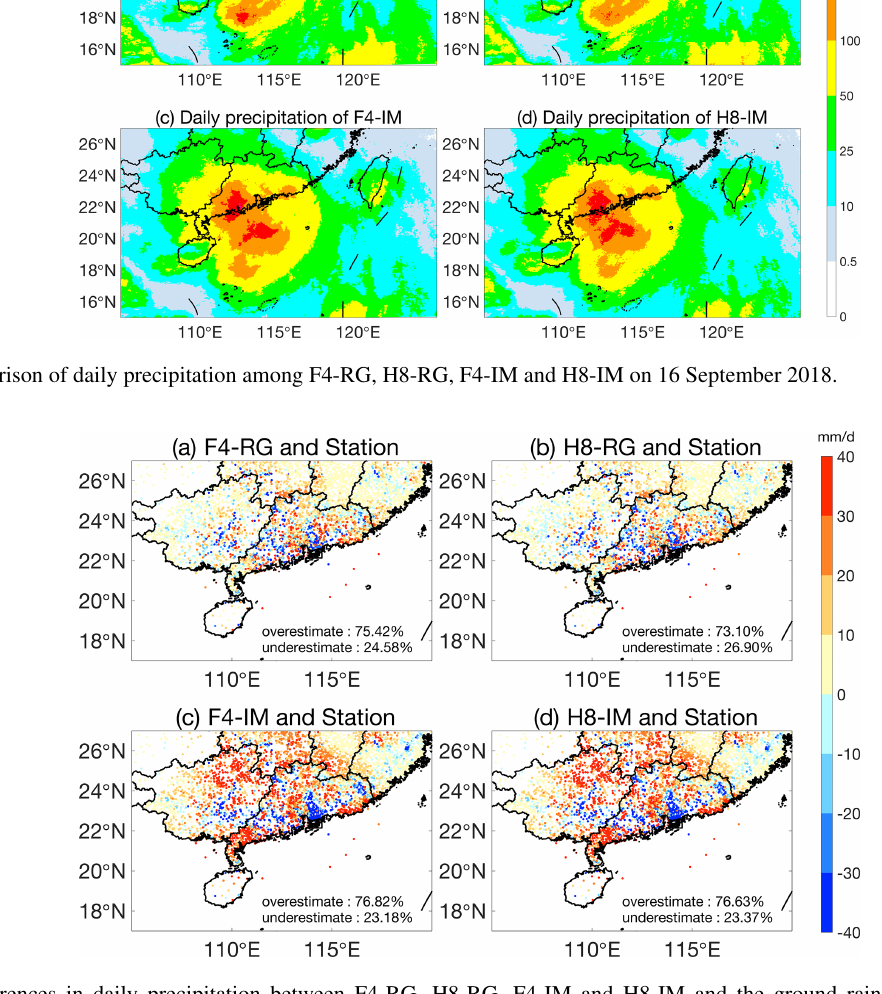
Figure 10. Differences in daily precipitation between F4-RG, H8-RG, F4-IM and H8-IM and the ground rain-gauge observations on 16 September